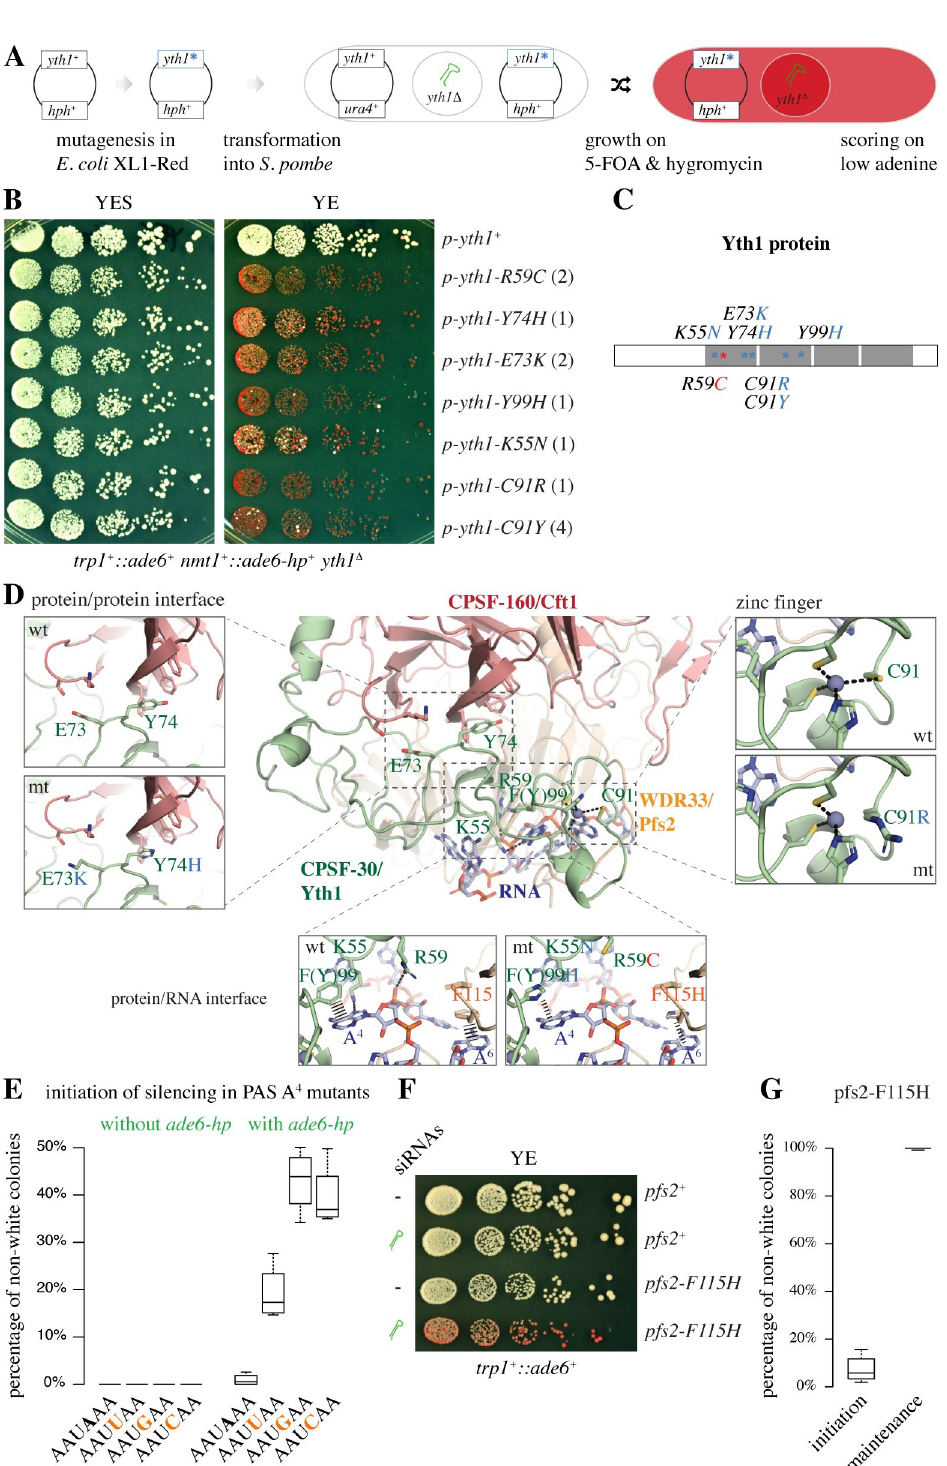
Fig 3. Weakening CPF/AAUAAA RNA interactions enables small-RNA-mediated epigenetic gene silencing. (A) Workflow of the yth1 + random mutagenesis screen. The mutant yth1 � plasmid library was transformed into the tester strain ( mst2 + ) lacking the endogenous yth1 + gene. The ade6-hp construct (primary siRNA source) is indicated in green. (B) yth1 mutants that display an ade6 + silencing phenotype on YE plates. The numbers in brackets denote how many times the respective mutation was recovered in the screen. (C) Domain organization of the Yth1 protein.